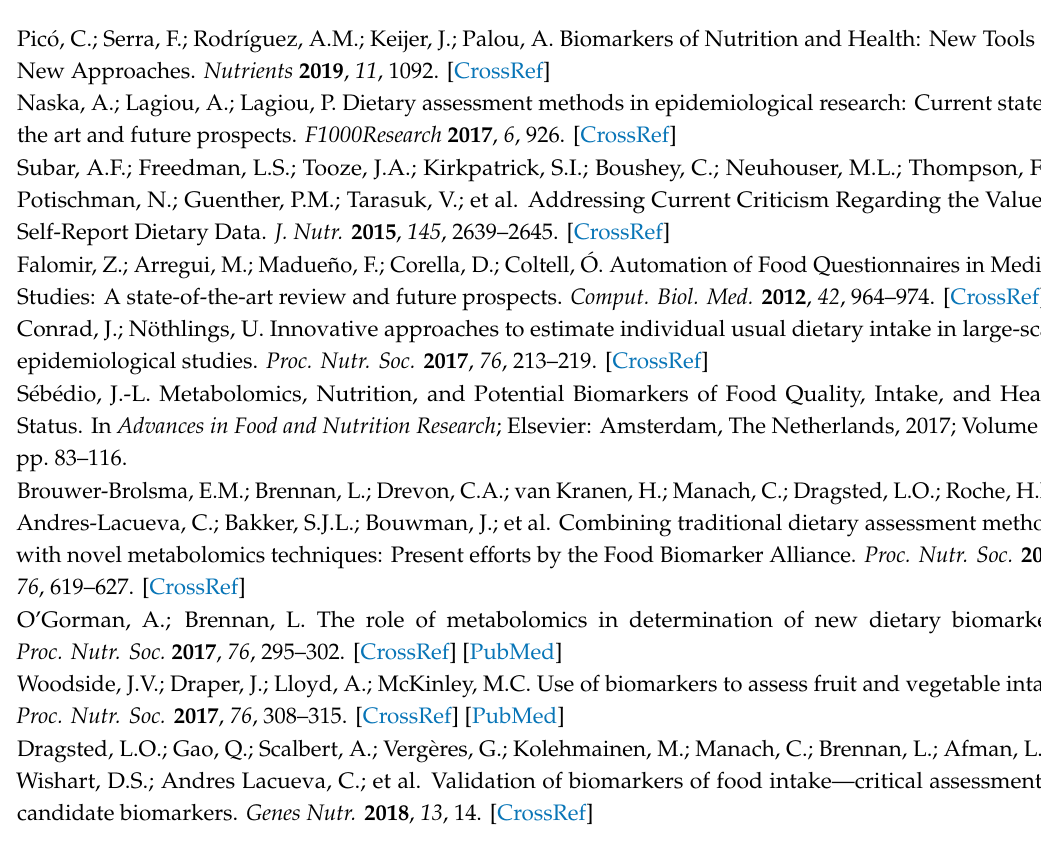
Figure S1: PCA score plot component 1 vs. component 2 of HILIC in negative ionization mode, explaining the 41.8% and 14.7% of the variance; Figure S2: PCA score plot component 1 vs. component 2 of RP in positive ionization mode, explaining the 47.1% and 11.7% of the variance; Figure S3: PCA score plot component 1 vs. component 2 of RP in negative ionization mode, explaining the 28.5% and 26.7% of the variance; Figure S4: OPLS-DA score plot based on the features with repeated measures ANOVA p -value ≤ 0.05, where the 94% of the total variance is explained; Figure S5: PCA score plot component 1 vs. component 2 obtained with the 43 features highlighted in the OPLS-DA with a P[corr] ≥ | 0.6 | , explaining the 79.3% and 9.6% of the variance; Figure S6: Extraction ion chromatograms of ions present in the LE function of HILIC pos and HILIC neg